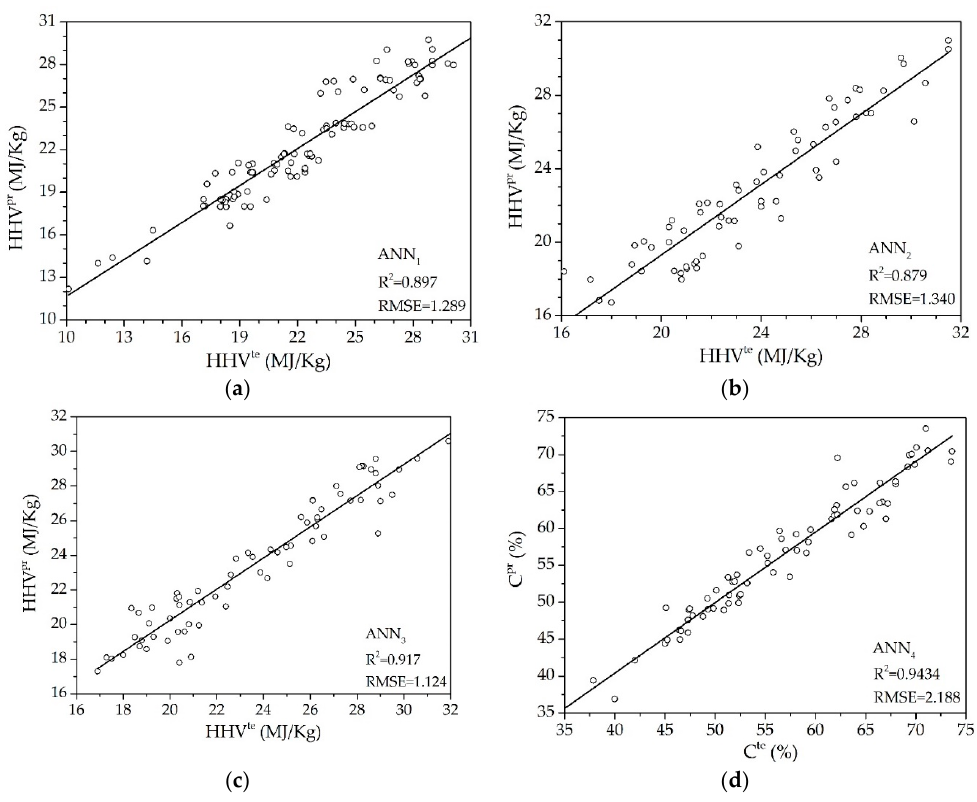
Figure 5. Regression analysis of predicted and experimental data ( a ) for higher heating values (HHV) using ANN 1 , ( b ) for HHV using ANN 2 , ( c ) for HHV using ANN 3 , and ( d ) for carbon using ANN 4 .